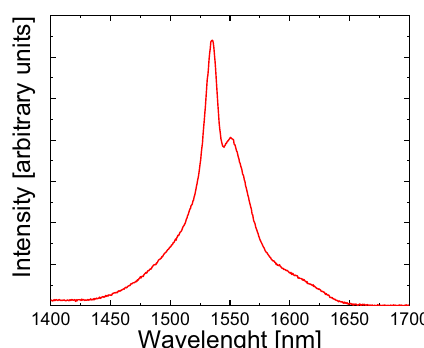
Fig. . Normalized photoluminescence spectra obtained exciting at 514.5 nm in prism coupling configuration the flexible SiO –HfO :Er 3+ planar 2 2